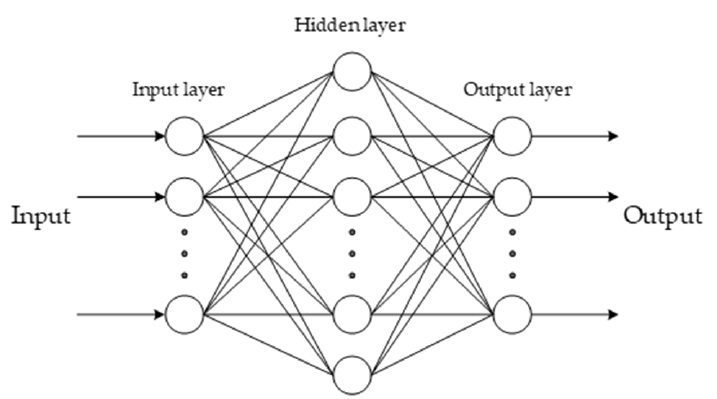
Figure 3. BP neural network topology.